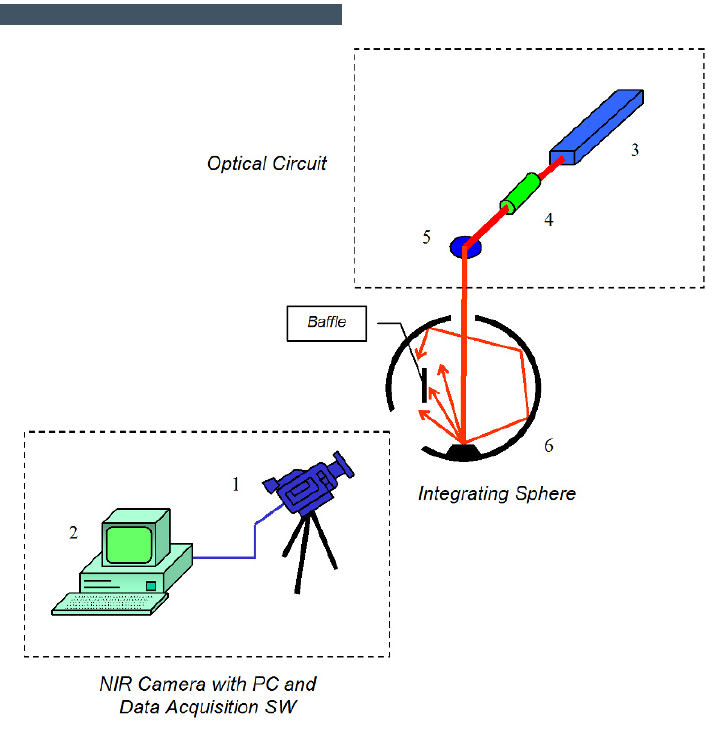
Figure 6. NIR camera calibration procedure (EMT-2).